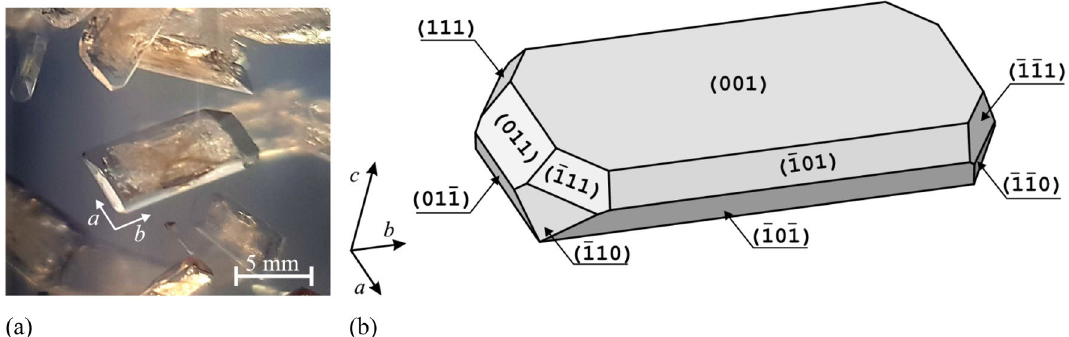
Figure 1. Struvite crystal ( a ) in metasilicate gel; ( b ) schematic representation of struvite habit with Miller indices of faces. Figure ( b ) reprinted from Ref. 20